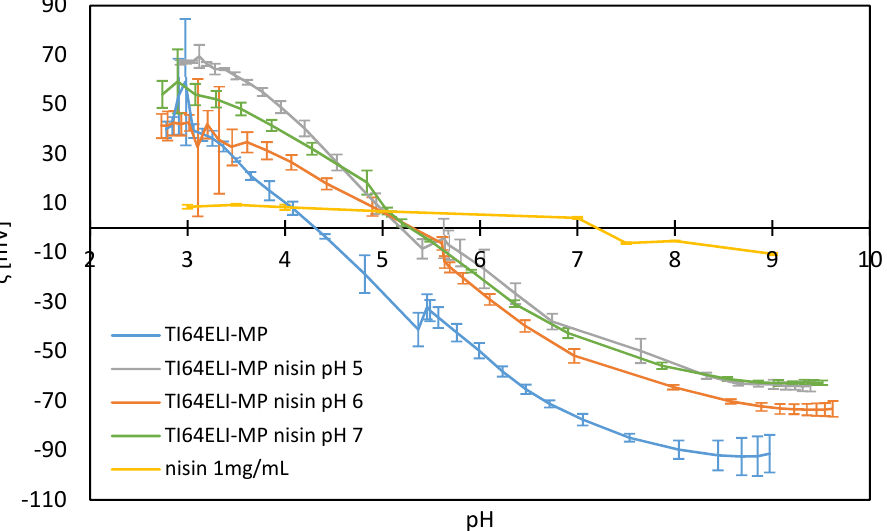
Figure 7. Zeta potential titration curves of the bare MP sample, surfaces functionalized with processes at different pH values, and a solution of nisin.